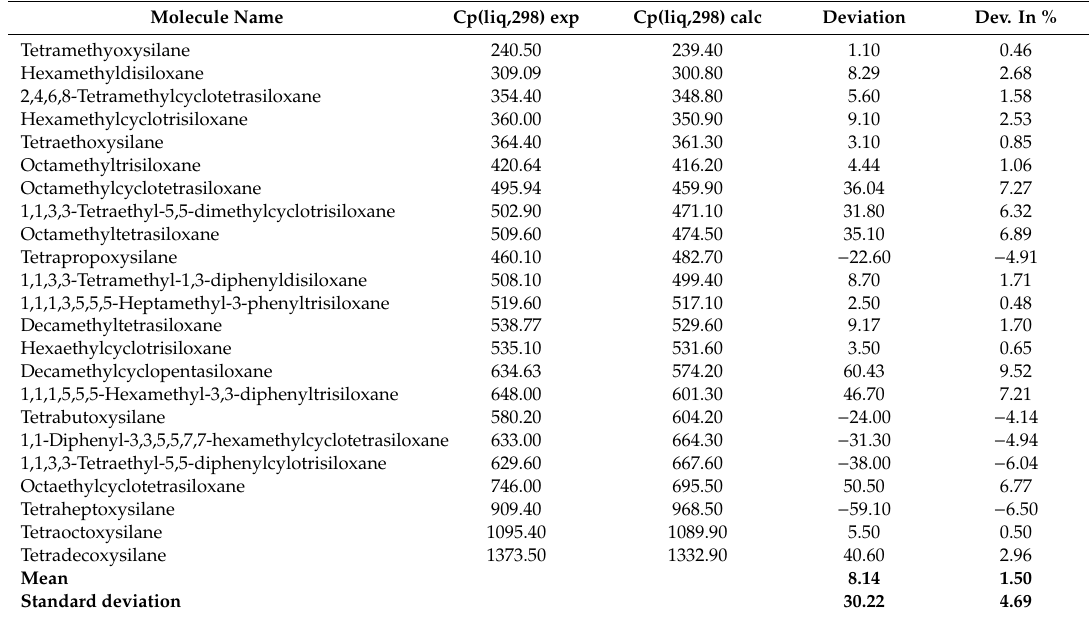
Table 4. Experimental and Equation (2)-calculated Cp(liq.298) of 23 siloxanes in J / mol / K. Molecule Name